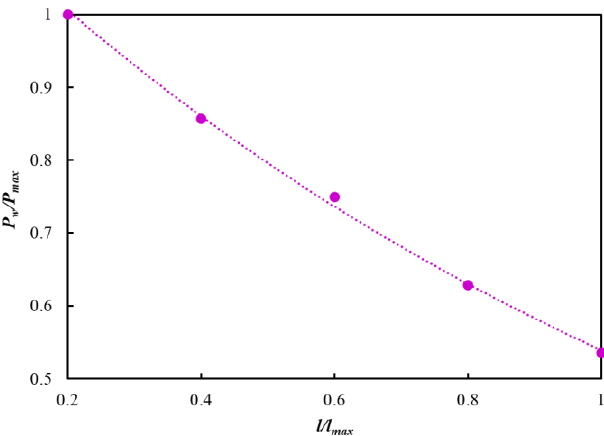
Figure 8. Perforation peak pressure at di ff erent positions of the wellbore. The abscissa l / l max is the ratio of the distance along the wellbore from the source of the explosion and the distance from the packer to the source of the explosion. The ordinate Pw / Pmax is the ratio of the peak pressure of perforation and the maximum peak pressure of perforation.